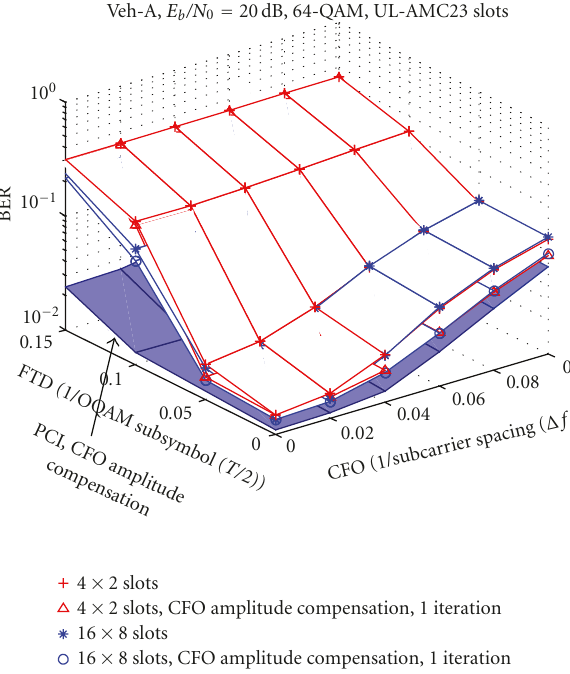
Figure 8: BER performance versus CFO and FTD for uplink transmission of 16 × 8 and 4 × 2 AMC23 slots in Vehicular-A channel at E b /N 0 = 20dB using 64-QAM. Di ff erent synchronization